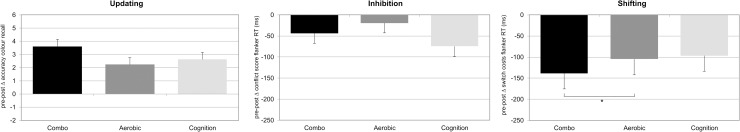
Means and error bars (representing the standard error of the mean) for the change (Δ) in the three core EFs (updating, inhibition, shifting) in the three groups between pre- and post-test.RT = reaction time. *p < .05 .